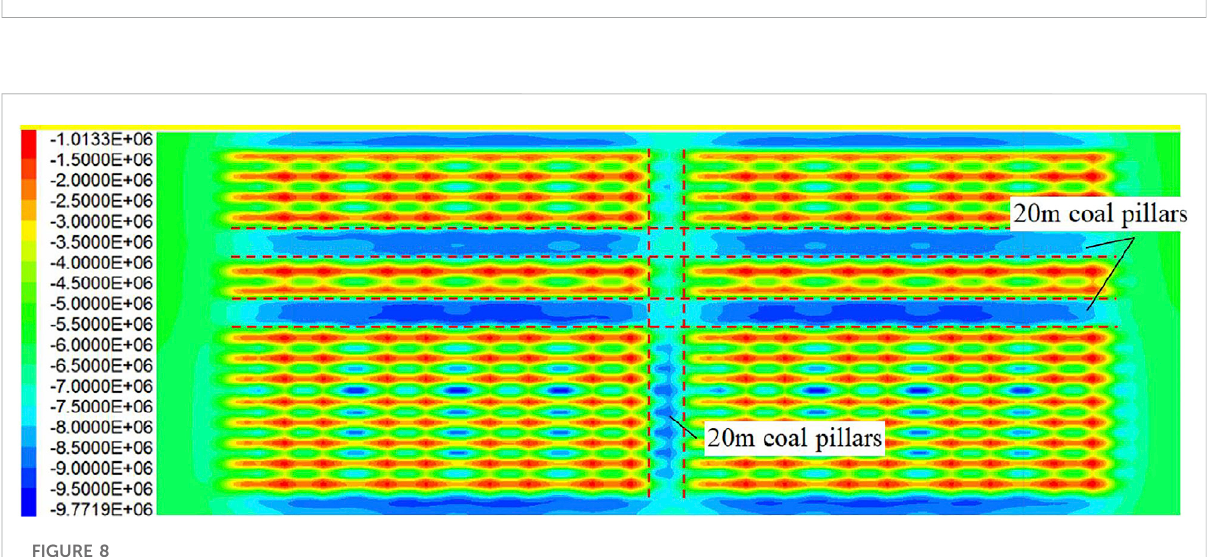
FIGURE 8 Vertical stress distribution of strata at 2 m on top of 3# coal seam